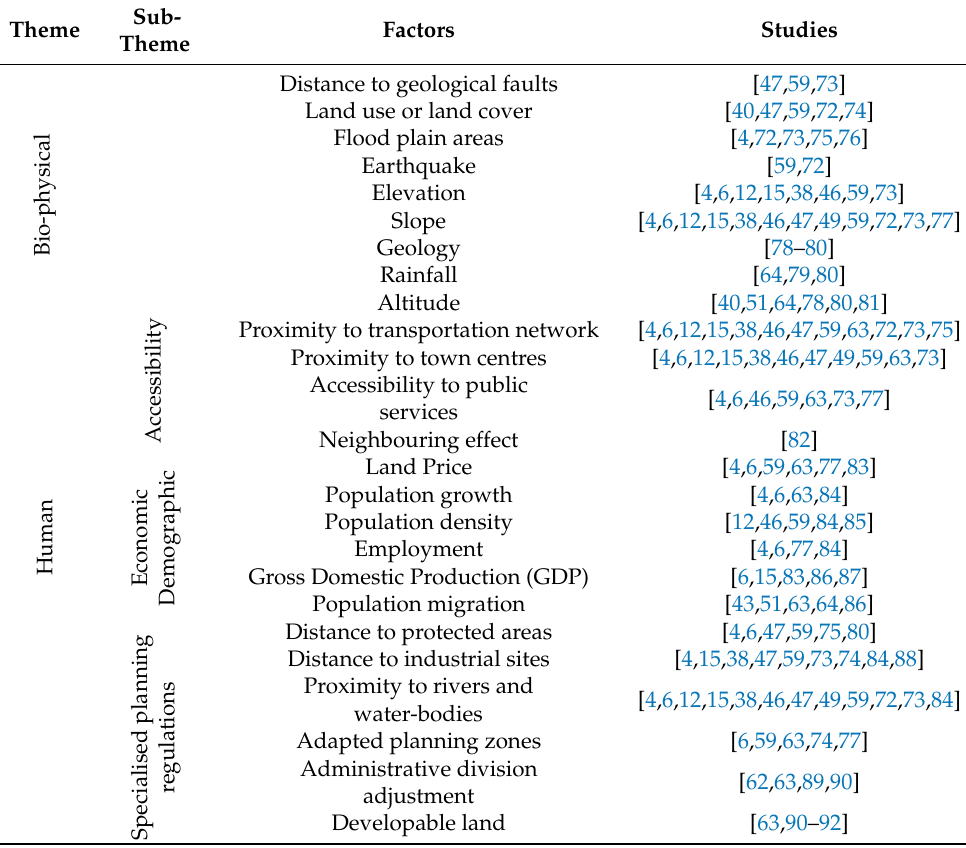
Table 1. Literature review of the factors driving